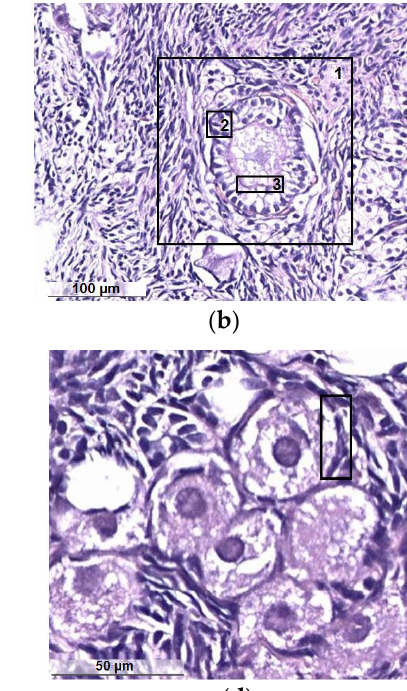
( d ) Figure 7. Histology of clinically healthy cat ovaries in the luteal phase: ( a ) corpus luteum; ( b ) atretic follicle; ( c ) follicular theca with an abundance of blood vessels: 1 — internal, 2 — external; ( d ) inter- stitial connective tissue.